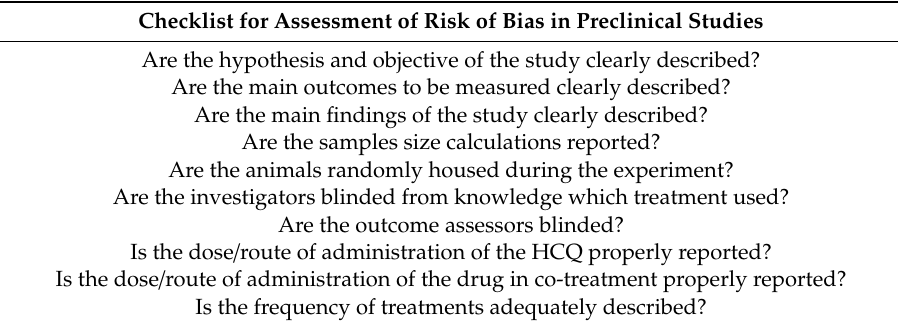
Table 4. Checklist for assessment of risk of bias in clinical studies [97]. Checklist for Assessment of Risk of Bias in Preclinical